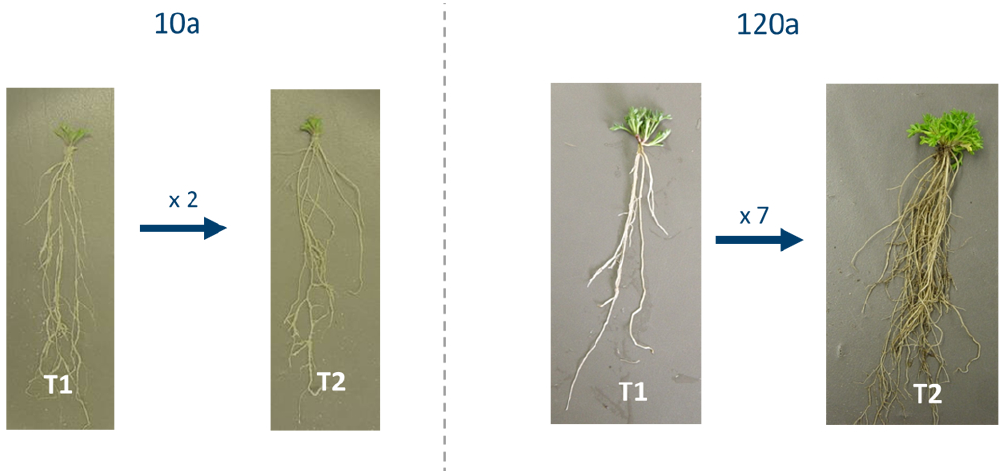
Fig. 4. Development of root biomass of L. alpina grown in soils obtained from the Damma chronosequence that have been ice free for 10 and 120yr, respectively, at two different points in time of plant development (2weeks and 8weeks of growth) in a green house